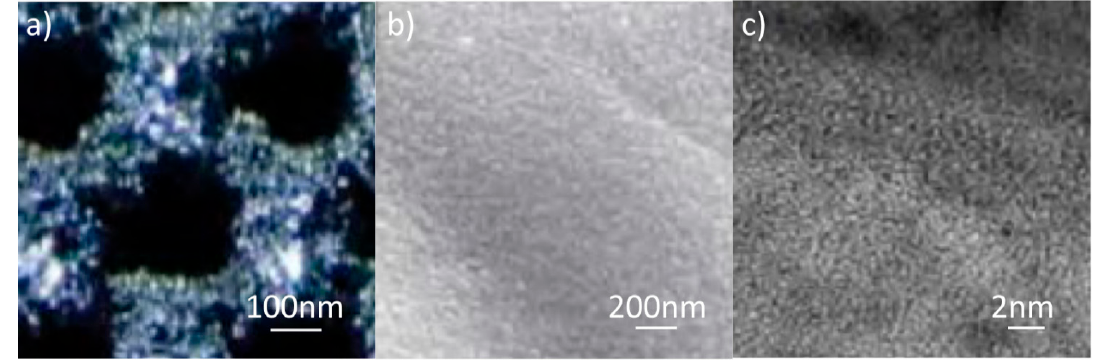
Figure 31. The surface structure of SLS titanium coated with TiO 2 coating during 1500 cycles; ( a ) Surface topography (stereoscopic microscope); ( b ) surface image (SEM); ( c ) amorphous TiO 2 coating layer (bottom) and titanium crystal structure (top) (HRTEM).